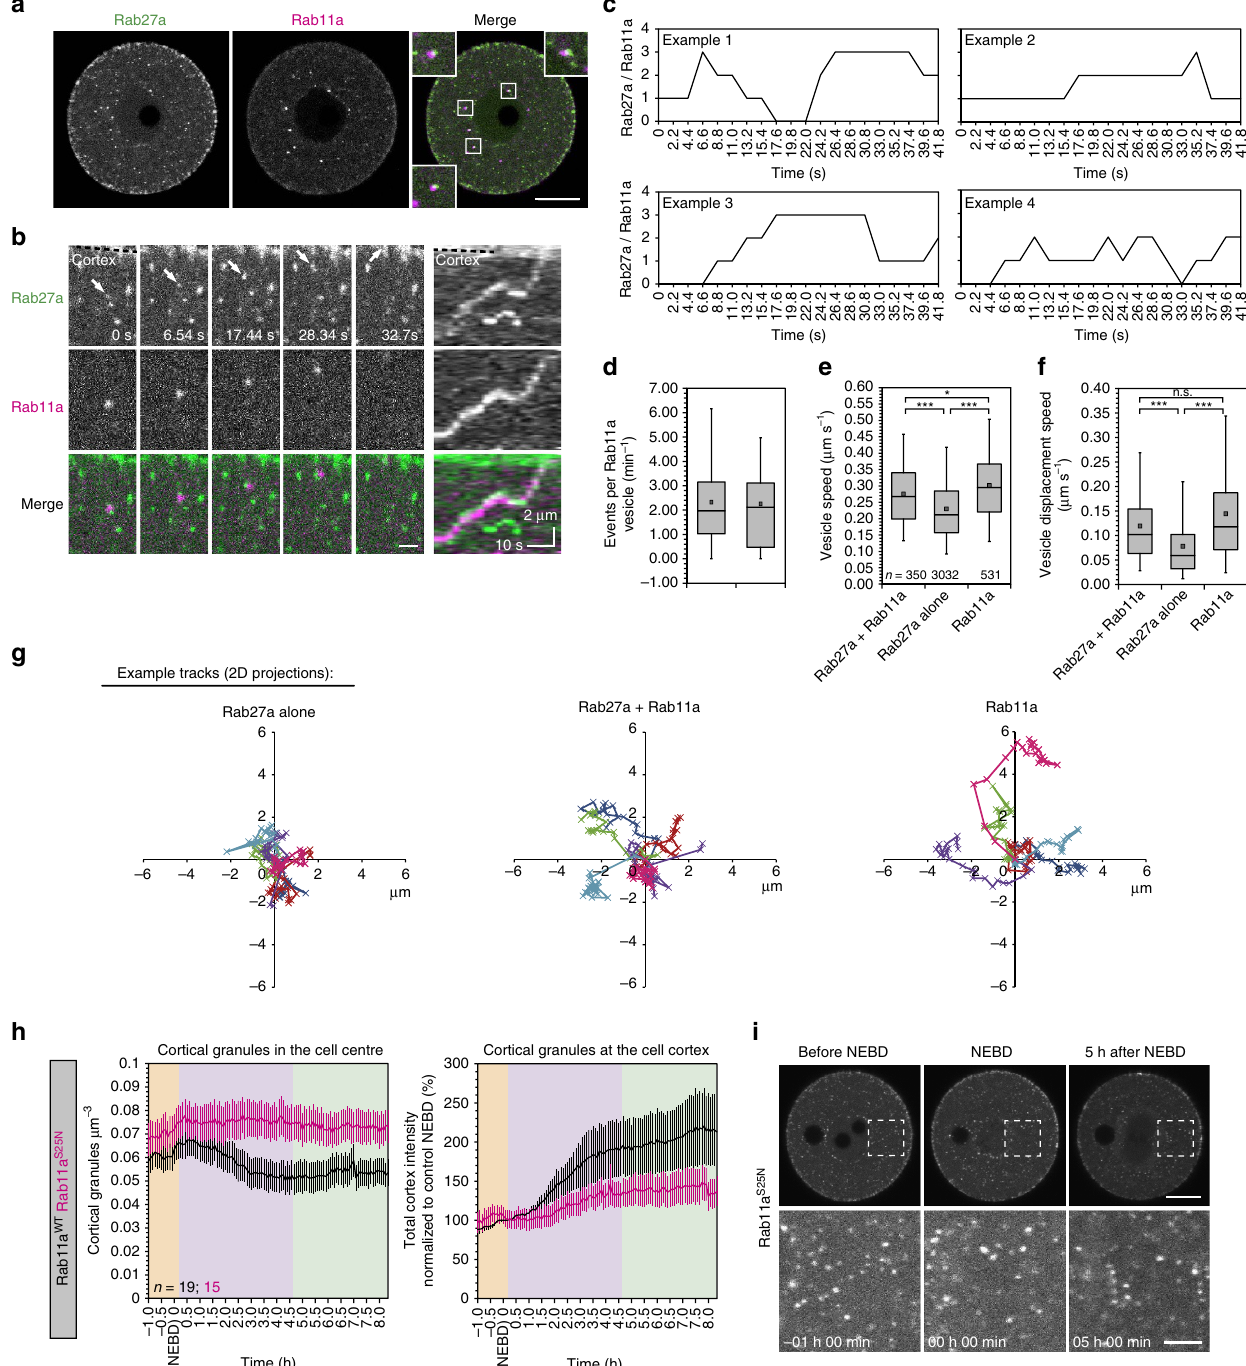
Figure 4 | Cortical granules are translocated to the cortex by hitchhiking on Rab11a vesicles. ( a ) Maximum intensity projections of confocal micrographs of an oocyte expressing GFP-Rab27a and mCherry-Rab11a. Note the close association between both types of vesicles (insets). Scale bar, 20 m m. ( b ) Example still images of a cortical granule (Rab27a, green; indicated by arrows) hitchhiking on a Rab11a vesicle (magenta) to reach the cortex (dotted line), with corresponding kymograph. Scale bar, 2 m m. ( c ) Quantification of the number of cortical granules associated to four example Rab11a vesicles. ( d ) Number of cortical granule hitchhiking ‘on’ and ‘off’ events per Rab11a vesicle per minute ( n ¼ 23 trajectories from three oocytes). Vesicle speed ( e ) and vesicle displacement speed ( f ) were quantified for cortical granules while associated to Rab11a vesicles (Rab27a þ Rab11a), cortical granules while not associated to Rab11a vesicles (Rab27a alone), and for Rab11a vesicles. Number of tracks used for quantification are indicated in e , from six oocytes. Tukey box plots in d , e and f show the median (line), mean (small square), interquartile range, and the 5th and 95th (whiskers). Significance levels: * P o 0.05, *** P o 0.001, analysed using Kruskal–Wallis’ ANOVA test from two experiments. ( g ) Representative example trajectories of the particle categories indicated in e and f (six trajectories per condition), projected in two dimensions. Duration of each trajectory is 52s. ( h ) Quantification of cortical granule translocation in the oocyte centre or cortex (mean ± s.e.m.) in oocytes expressing Rab11a S25N or wild-type Rab11a. ( i ) Representative still images (maximum intensity projections of confocal Z sections) of oocytes expressing Rab11a S25N . Control images are included in Supplementary Fig. 2. Scale bars, 20 m m (overview) and 5 m m